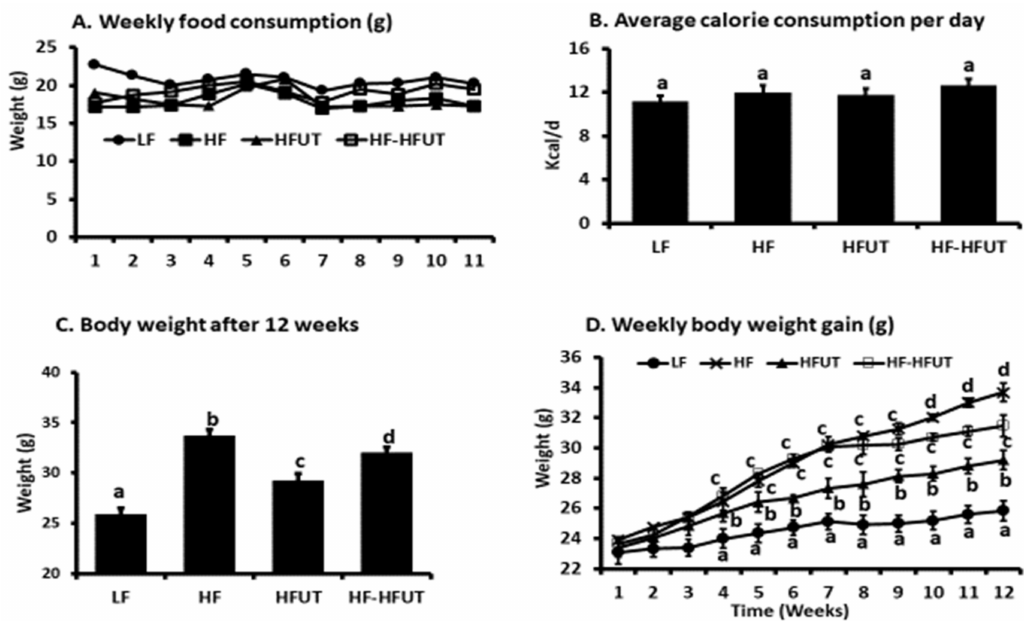
Figure 1. Supplementation with U. dioica vegetable lowers body weight. Mice were fed isocaloric diets for 12 weeks. ( A ) Weekly food consumption was not di ff erent among all groups. ( B ) The calculated calorie consumption per day was not di ff erent among all groups ( p > 0.05; n = 8–9). ( C ) The HF diet induced greater body weight gain compared to LF diet. Supplementation of the HF diet with UT vegetable from beginning of the study lowered body weight compared to the HF diet ( p < 0.005; n =